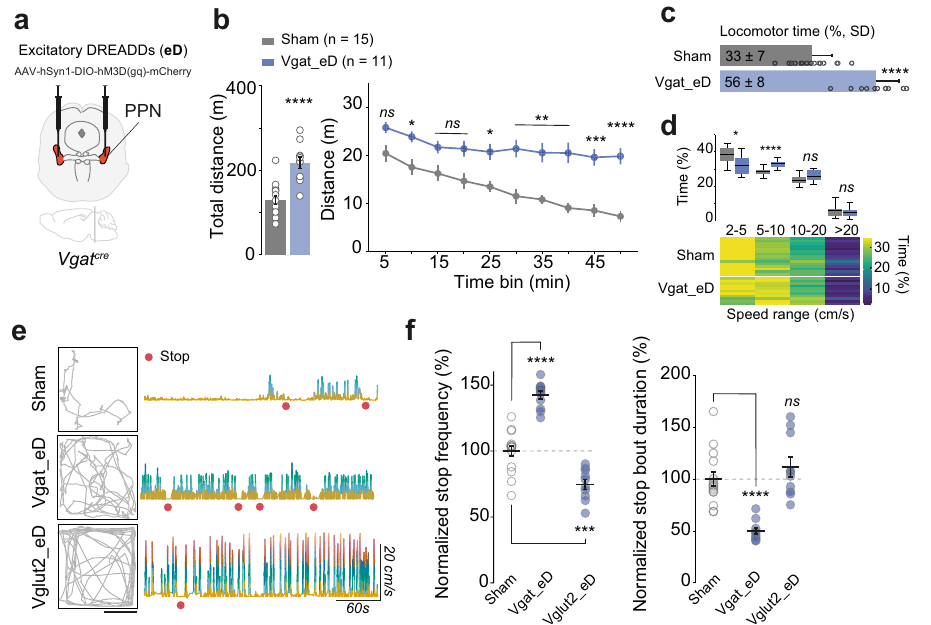
Fig. 8 Bilateral chemogenetic activation of GABAergic PPN neurons promotes locomotor activity which is fl anked by numerous brief stop bouts. a Viral strategy to bilaterally express excitatory DREADDs (eD) in GABAergic neurons of the caudal PPN. b Total distance moved by Sham (gray) and Vgat_eD (blue) mice after CNO (bar graph) (two-tailed, t -test). Timeline effect of CNO (line graph) (Two-way RM ANOVA, Geisser – Greenhouse correction followed by Bonferroni ’ s multiple comparison, the report shows post hoc results). Data are presented as mean ± SEM. c Percentage of locomotor time (speed above >2 cm/s) during Open Field test (two-tailed, t -test). Data are presented as mean ± SD. d Upper panel, speed range in Sham (gray) and Vgat_eD (blue) mice with min-to-max boxplots (Two-way RM ANOVA, Geisser – Greenhouse correction, with report for Bonferroni ’ s multiple comparison). Lower panel, heat map with individual mice in horizontal lines, and color code for the percentage of time in each speed range. e Representative tracks (minute 45 to 50, scale 25 cm) of each experimental group (Sham, Vgat_eD, Vglut2_eD) in the Open Field after CNO injection. Right panel shows the instantaneous speed pro fi le for the three tracks (speed follows the divergent color scheme to facilitate reading). CNO-mediated activation of Vgat- or Vglut2 PPN neurons resulted in signi fi cant increases in the distance traveled but with different locomotor periodicity. Red dots indicate stop events in absence of in-place behavior, as identi fi ed by the tracking software (see methods for detailed de fi nition). f Stop events counted across the 50 min Open Field test with all groups having received CNO treatment 5 min prior to start. Data are normalized to Sham average (dashed line). Individual data points (circles) and group mean ± SEM (black lines). Left panel, stop frequency. Right panel, average stop bout duration (Brown – Forsythe and Welch ANOVA, report shows Dunnett ’ s multiple comparison (T3) to Sham group). Vgat_eD CNO mice show a higher number of brief stop bouts. Data composed of 15 Sham CNO ; 10 Vglut2_eD CNO [same cohort as in Fig. 1], and 11 Vgat_eD CNO mice [these Open Field experiments were performed in parallel]. See detailed stats in Table S5. Source data are provided as a Source Data fi